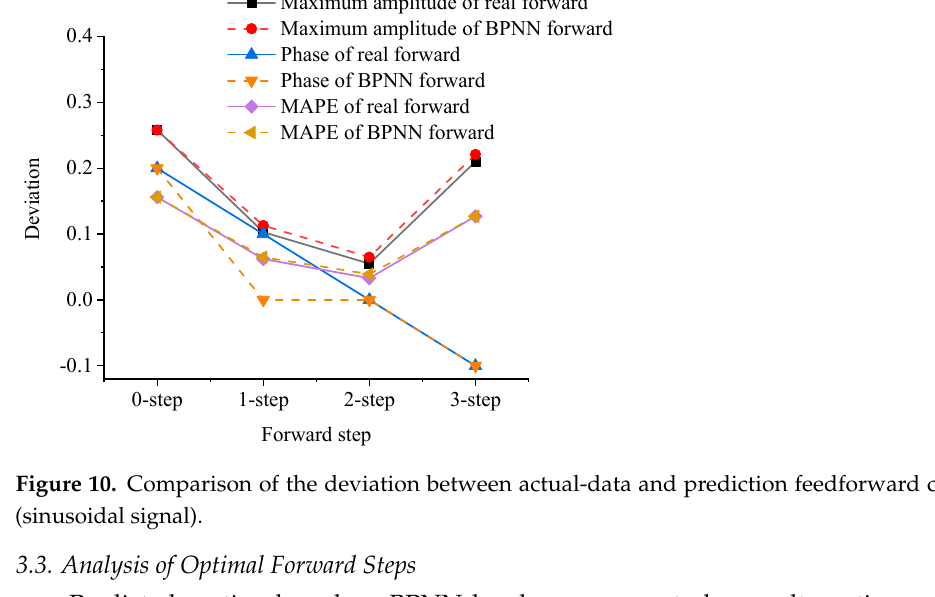
Table 2. Amplitude deviation with di ff erent numbers of prediction steps (